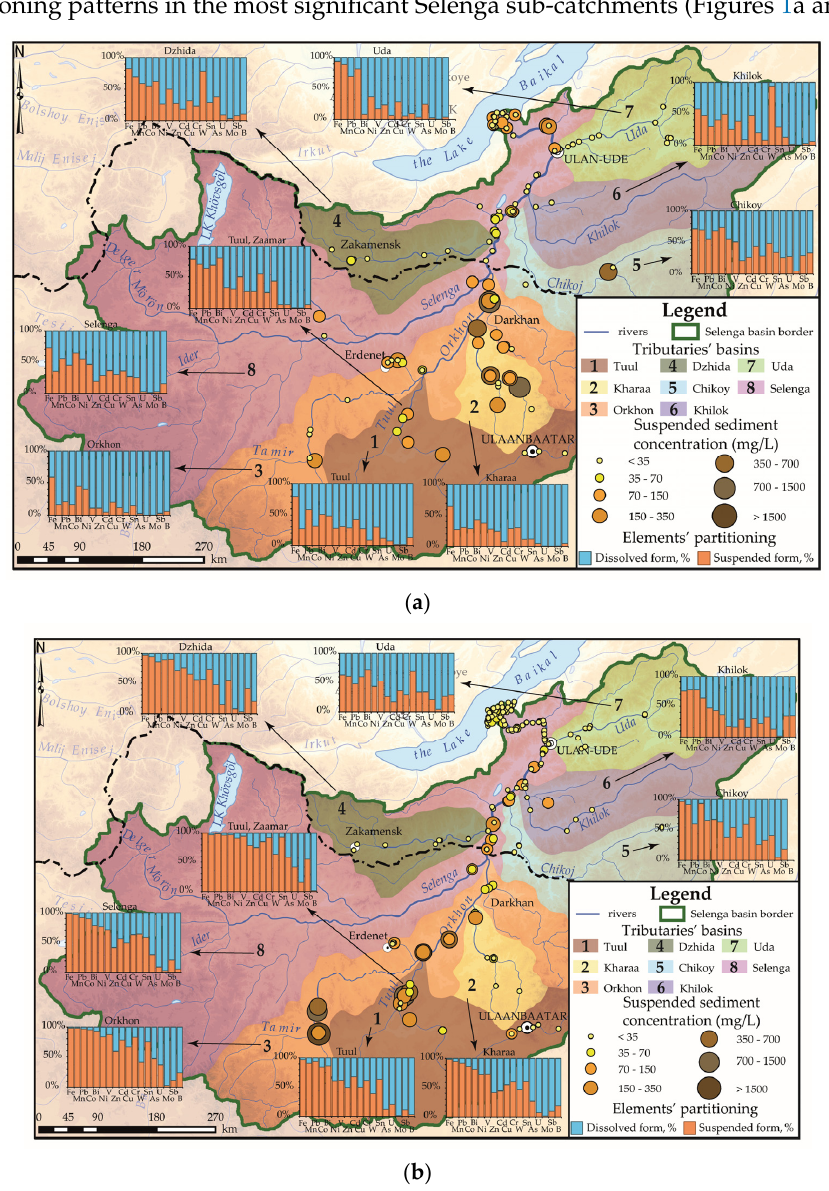
Figure 2. Metal partitioning and suspended sediment concentration during (on average): ( a ) low water period, ( b ) high water period.